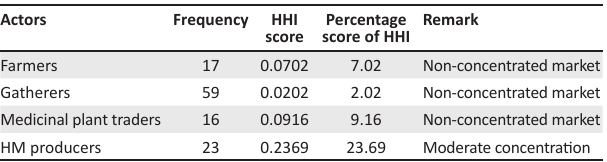
TABLE 4: Market concentration. Actors